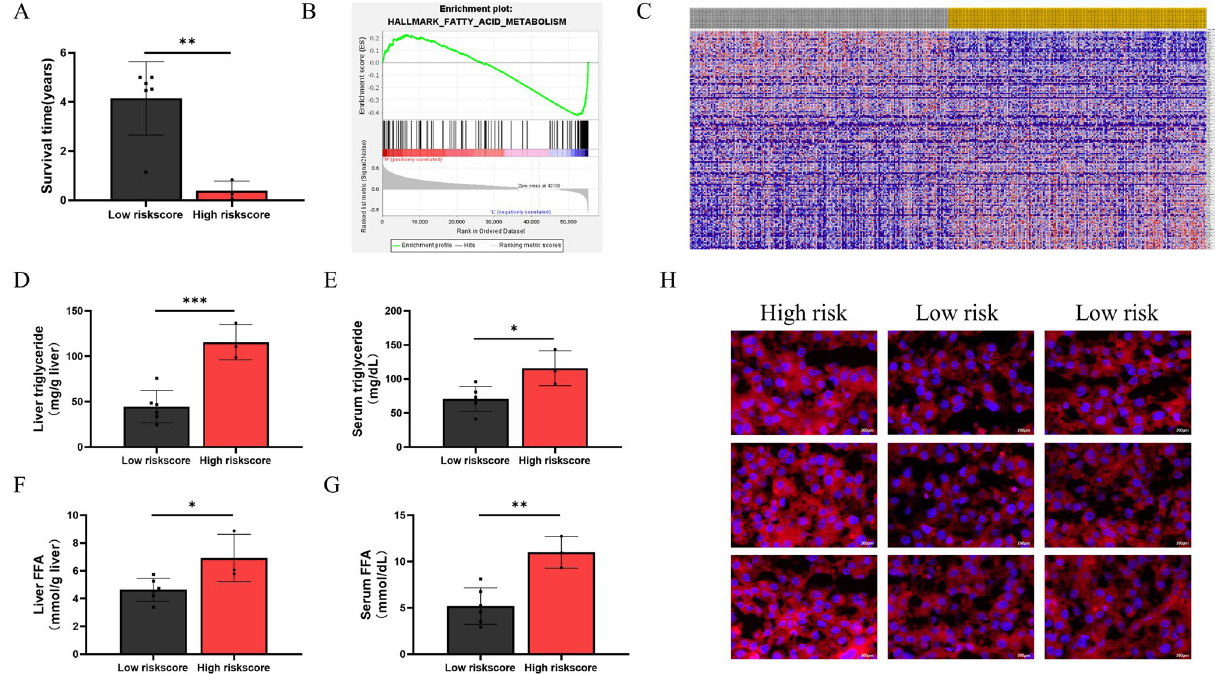
Figure 7. Risk score is associated with lipid metabolism disorders and prognosis in HCC patients. ( A ) Mean survival time between high-risk and low-risk groups (patients treated at People’s Hospital of Zhengzhou University). ( B ) Enrichment for the gene signature associated fatty acid metabolism between the low and high risk groups of TCGA dataset. ( C ) Heatmap (using “pheatmap” R package, https:// cran.r- proje ct. org/ bin/ windo ws/ base/ old/4. 1.3/) showed differential expression of genes across all samples in TCGA-LIHC datasets. ( D – G ) TG and FAA levels in tumor tissue and serum of patients in high-risk and low-risk groups (patients treated at People’s Hospital of Zhengzhou University). ( H ) Nile red staining of tumor tissue from high-risk and low-risk patients (patients treated at People’s Hospital of Zhengzhou University (Scale bar, 200